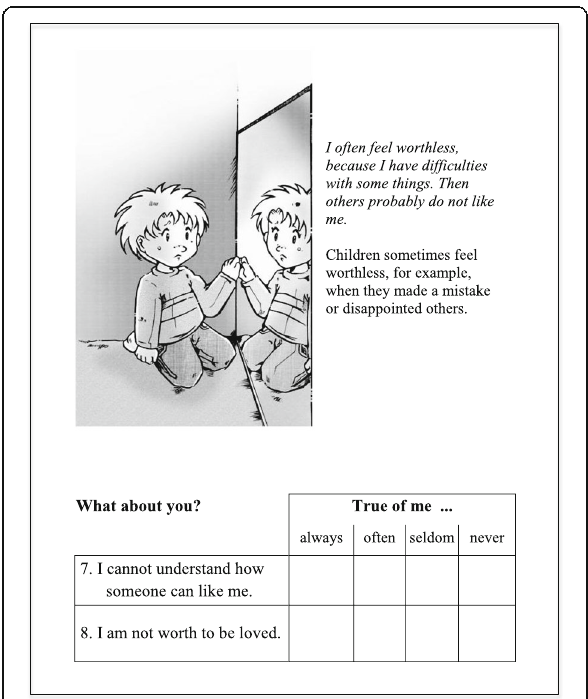
Fig. 1 The schema defectiveness/shame with a cartoon, additional explanation of what is meant and the two items, selected for the